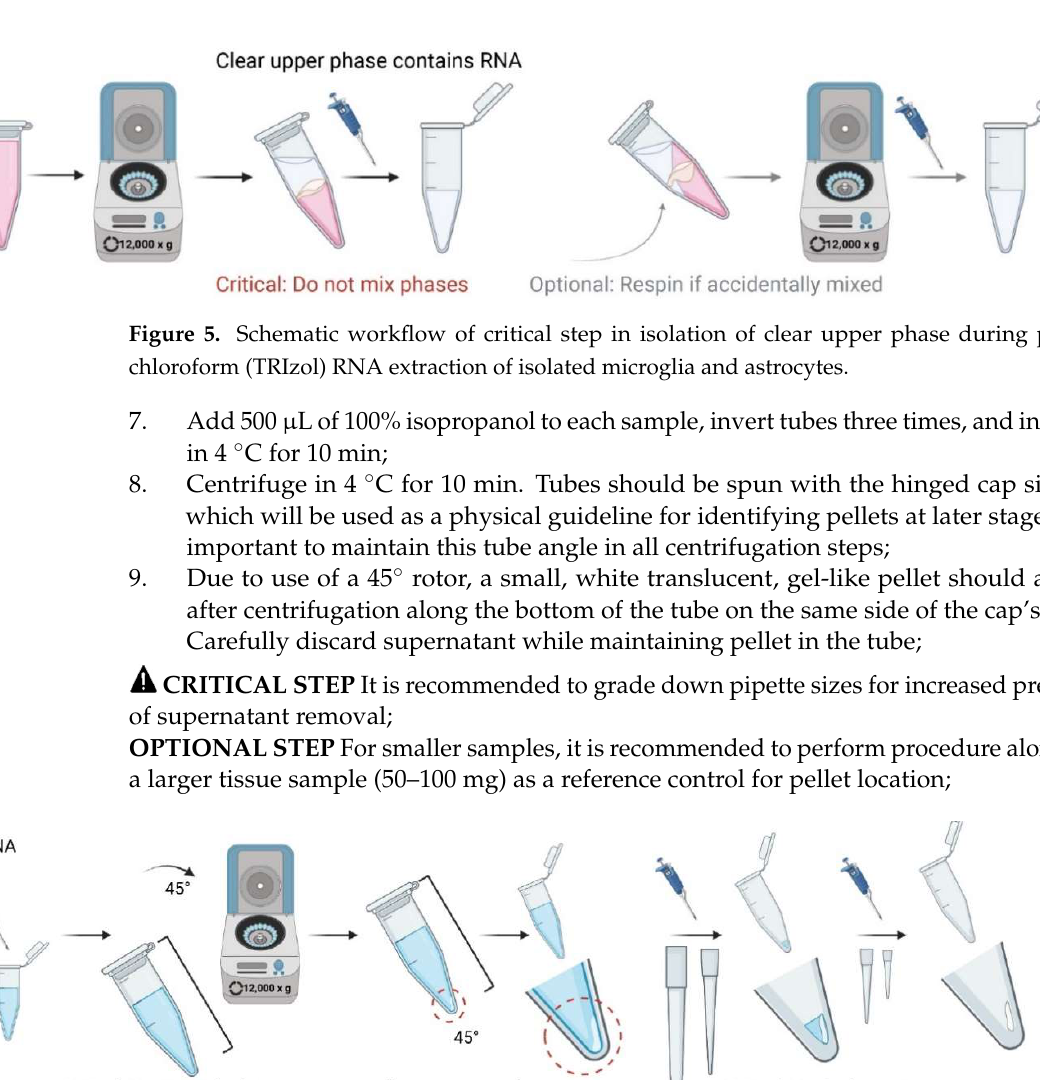
Figure 7. Schematic workflow of final key steps in the isolation of RNA from microglia and astrocytes.